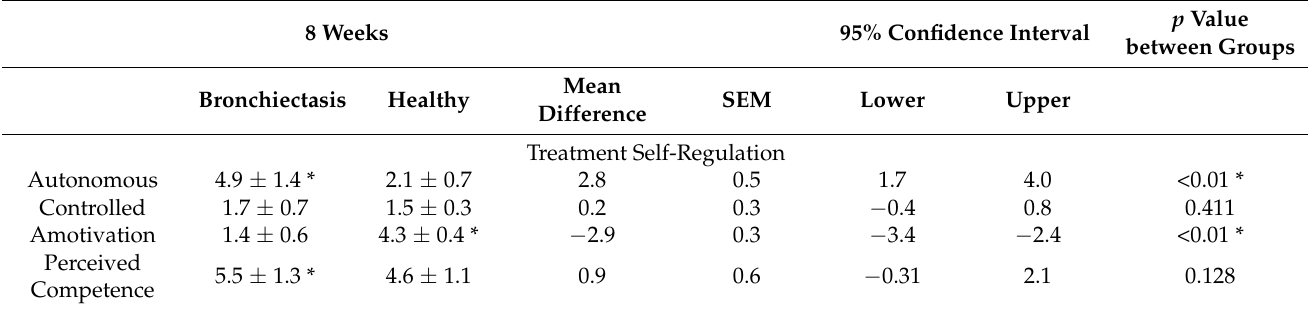
Table 2. Meaningful clinical difference between baseline, eight weeks and 16 weeks in adults with bronchiectasis.